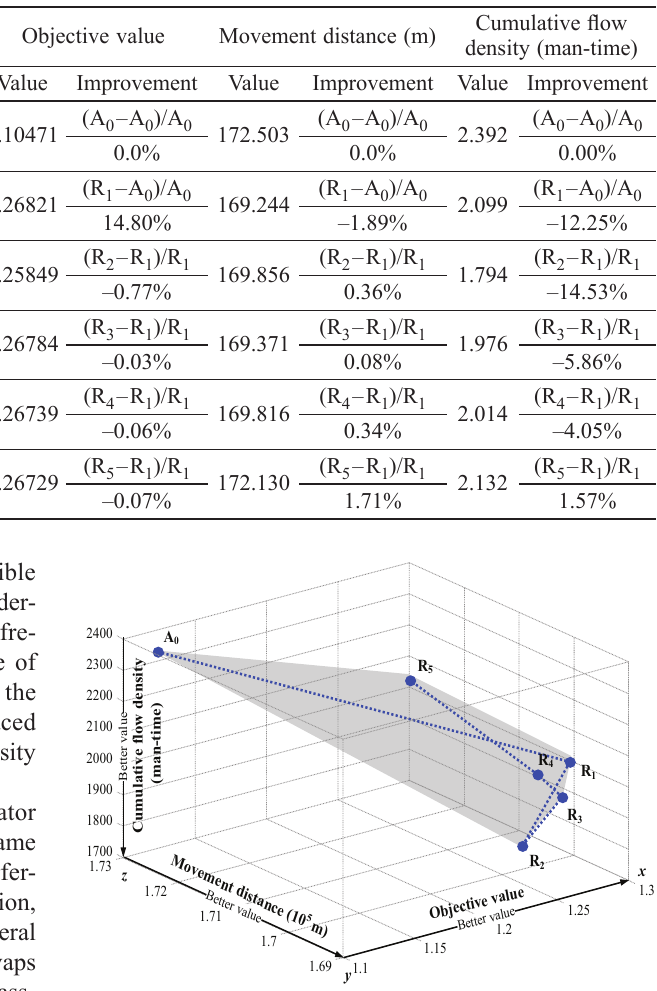
Fig. 8. Comparison of the performances in different function-space